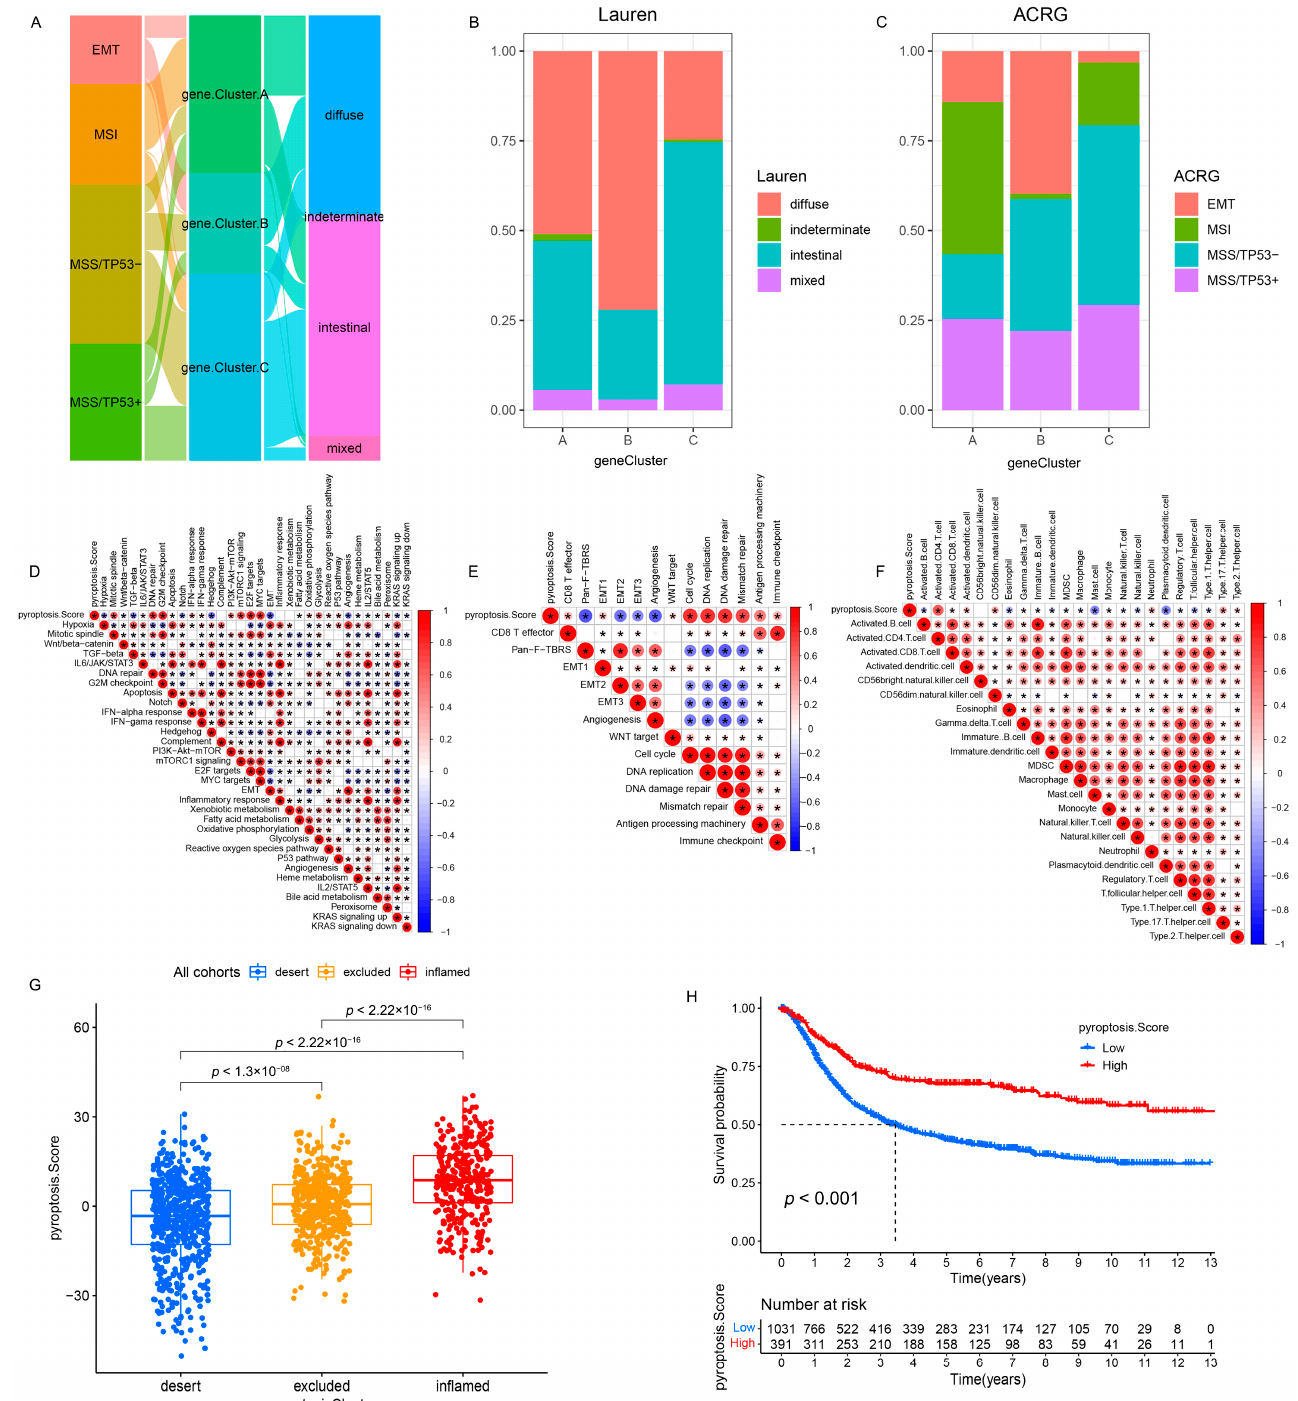
Figure 6. Correlation between the PS and TME status and relevant biological signatures in the meta-cohort. ( A ) Alluvial diagram of gene clusters in groups with different ACRG subtypes and Lauren subtypes in the GSE62254/ACRG cohort. ( B ) The proportion of Lauren subtypes in three gene clusters in the GSE62254/ACRG cohort. ( C ) The proportion of ACRG subtypes in three gene clusters in the GSE62254/ACRG cohort. ( D – F ) The correlation between the PS and Hallmark pathways ( D ), Mariathasan et al. constructed gene sets ( E ), and TME infiltration cells ( F ) using a Spearman analysis in the meta-cohort. A negative correlation was marked with blue and a positive correlation with red. p < 0.05. ( G ) Differences in the PS among the three phenotypes in the meta-cohort ( p < 0.001, Kruskal–Wallis test). ( H ) Kaplan–Meier analysis for patients with high and low PS subgroups in the meta-cohort (Log-rank test: p <